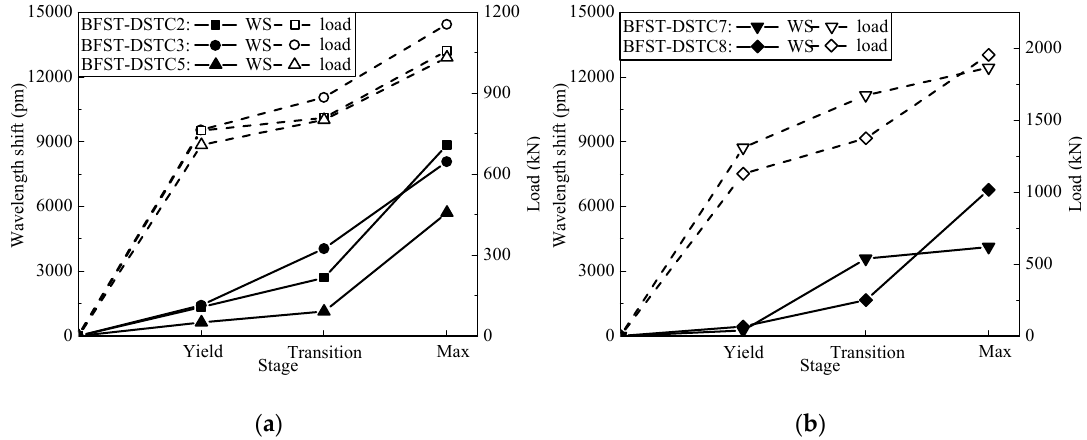
Figure 12. Relationship between the outer tube’s WS and the load at each stage: ( a ) Specimens with NSC; ( b ) Specimens with HSC.